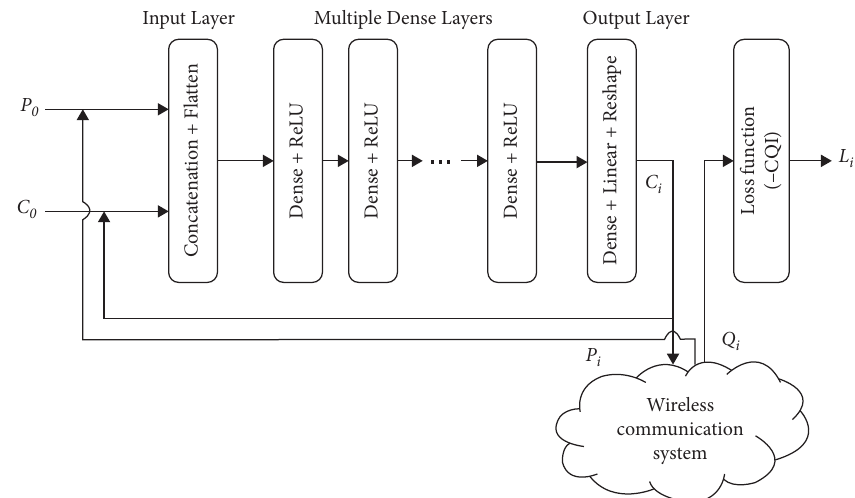
Figure 3: DNN structure and system feedback information fow for the unsupervised learning